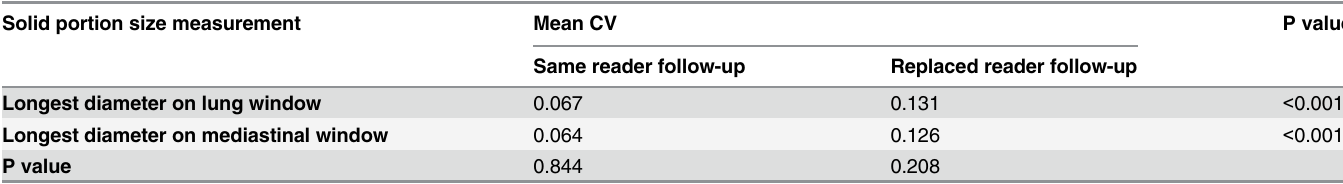
Table 3. Coefficient of variation (CV) comparisons of solid portion size measurements. Solid portion size